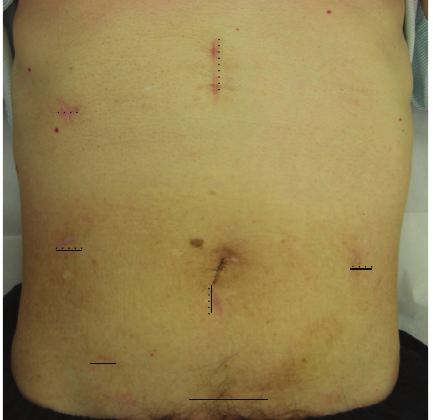
Figure 1: Port sites and minilaparotomy incision after sigmoidec- tomy and gastrectomy. Laparoscopic-assisted sigmoidectomy was performed via four ports and a 5cm mini-laparotomy of the lower abdomen (solid lines). Laparoscopy-assisted distal gastrectomy was performed via four ports and a 4cm mini-laparotomy of the upper abdomen (dotted